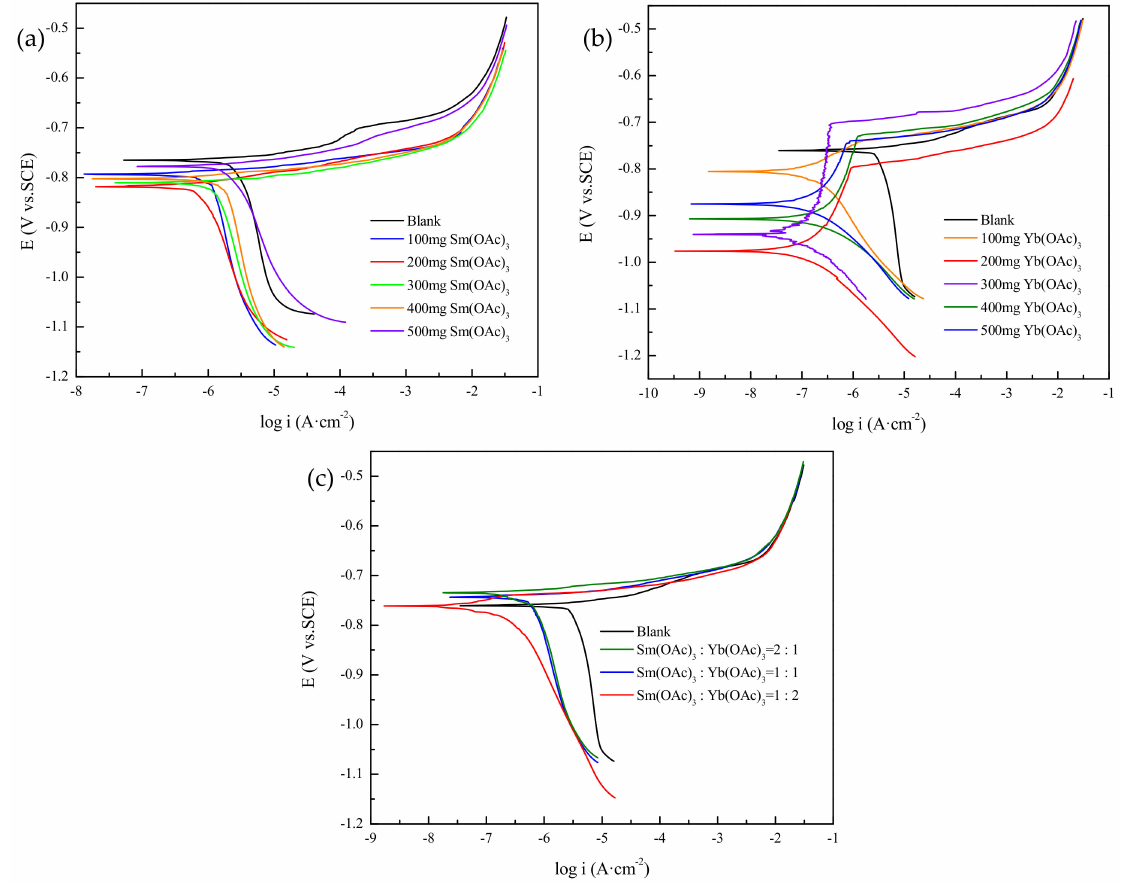
Figure 2. Potentiodynamic polarization curves of aluminum anode in 3.5 wt.% NaCl with different additives: ( a ) samarium acetate, ( b ) ytterbium acetate, and ( c ) mixed corrosion